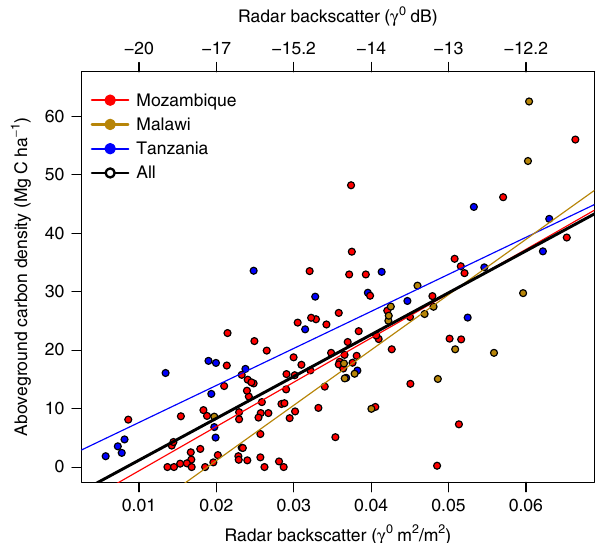
Fig. 6 Biomass-backscatter relationship. HV radar backscatter ( γ 0 ) plotted against aboveground woody carbon stocks for 137 sites across the